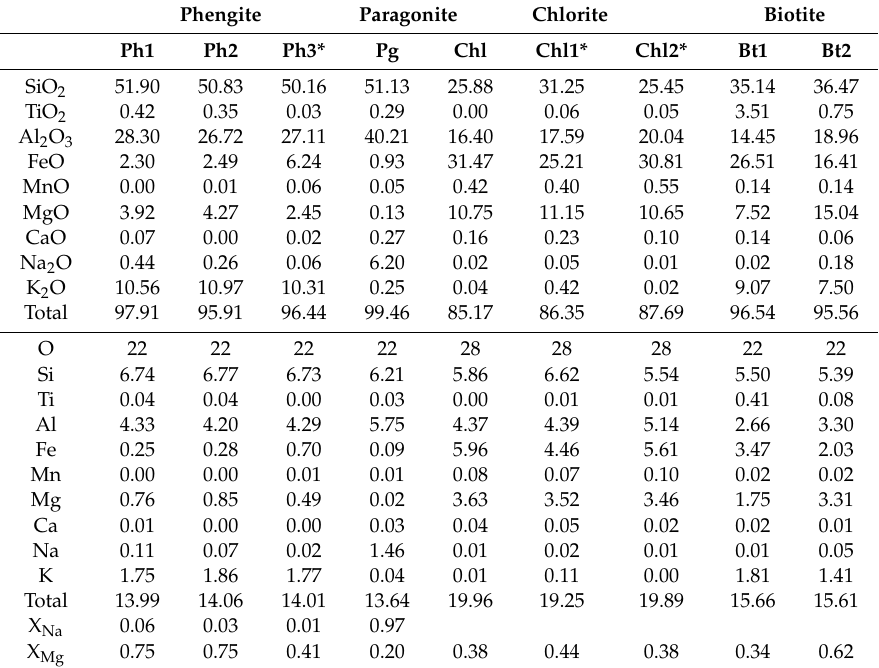
Table 4. chemical compositions of phengite, paragonite, chlorite, and biotite from the eclogites and amphibolitized